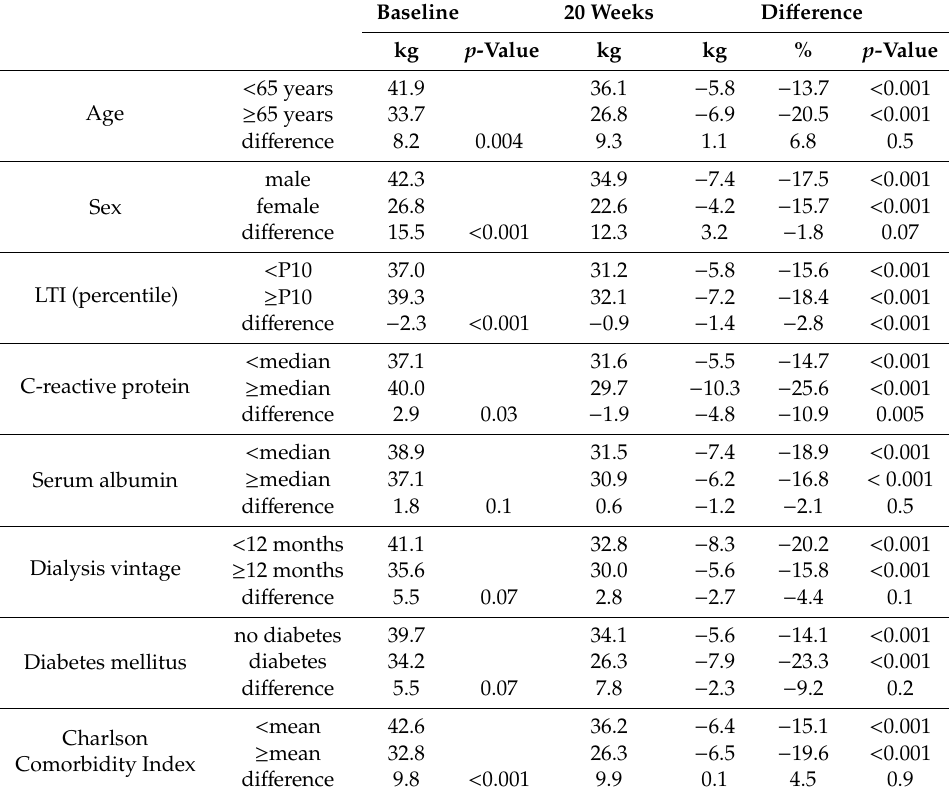
Table 3. Lean tissue mass at baseline and after 20 weeks and the e ff ect of